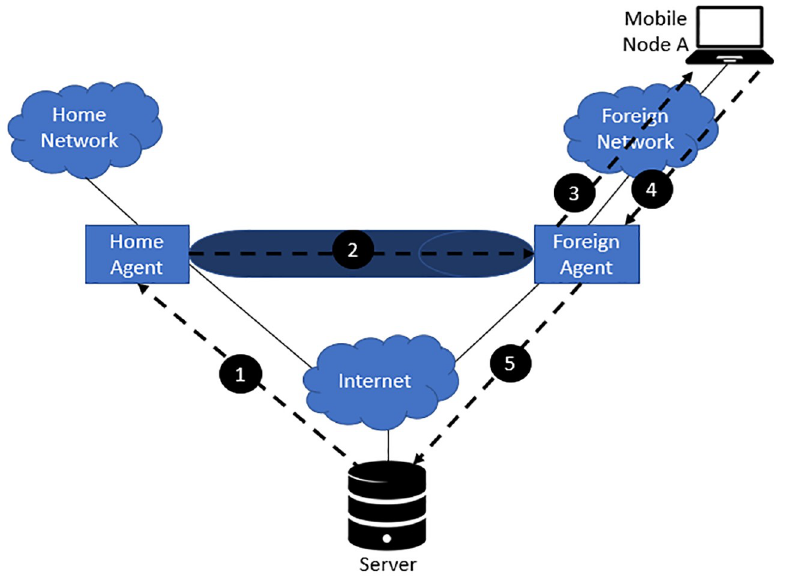
Fig 1. Triangle routing in mobile